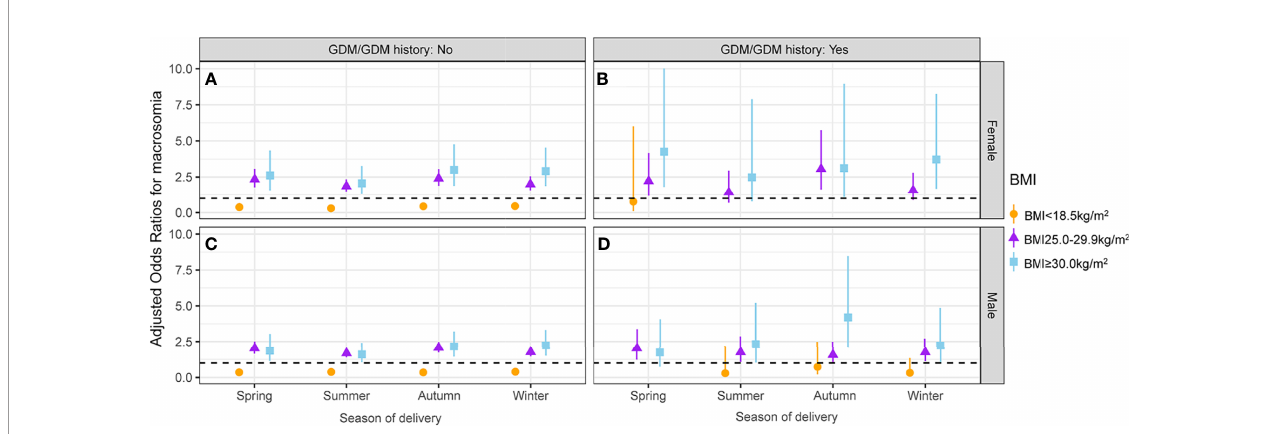
FIGURE 5 | Association between maternal fi rst-trimester BMI and macrosomia strati fi ed by GDM/GDM history status, fetal sex, and season of delivery. The association between maternal fi rst-trimester BMI and macrosomia in female fetuses whose mothers without GDM/GDM history (A) , female fetuses whose mothers with GDM/GDM history (B) , male fetuses whose mothers without GDM/GDM history (C) and male fetuses whose mothers with GDM/GDM history (D) . BMI, body mass index; GDM, gestational diabetes